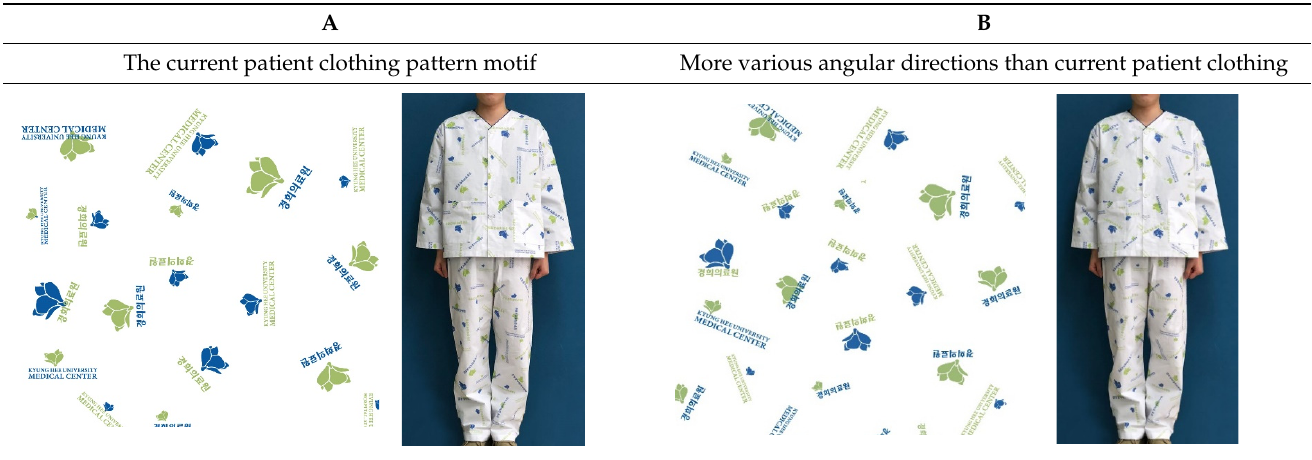
Table 4. Aesthetic healing characteristics: Patient clothing design stimulus.